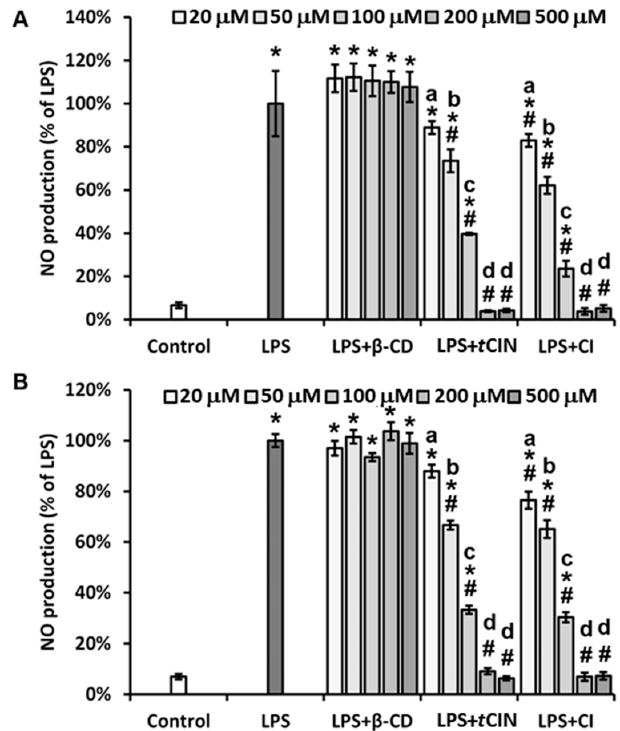
Figure 5. Inhibition of nitric oxide (NO) production by the trans -cinnamaldehyde ( t CIN) and β -cyclodextrin ( β -CD) inclusion complex (CI). RAW 264.7 macrophages were seeded in 96-well plates